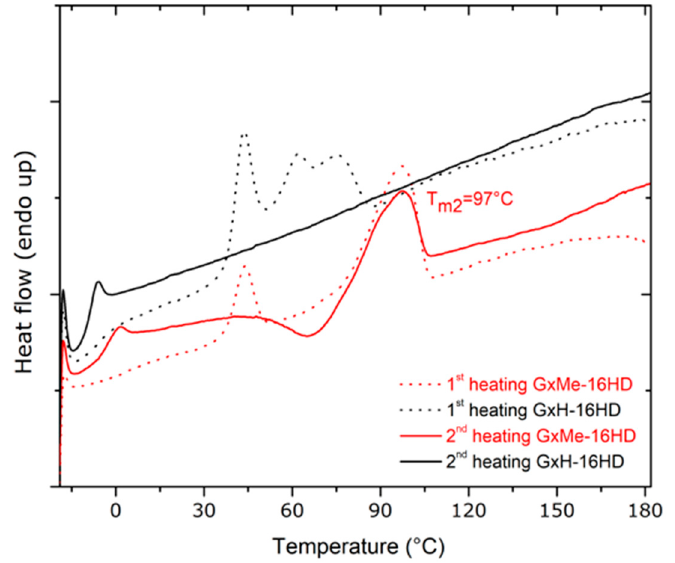
Figure 6. DSC curves of GxMe-16HD and GxH-16HD displaying the melting behaviour during the first and second heating cycle when heating with 10 °C/min.